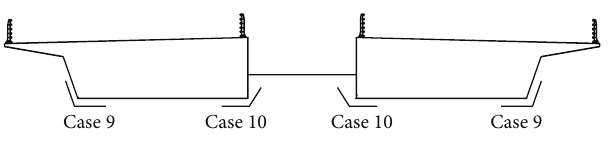
Figure 6: Arrangement diagram of